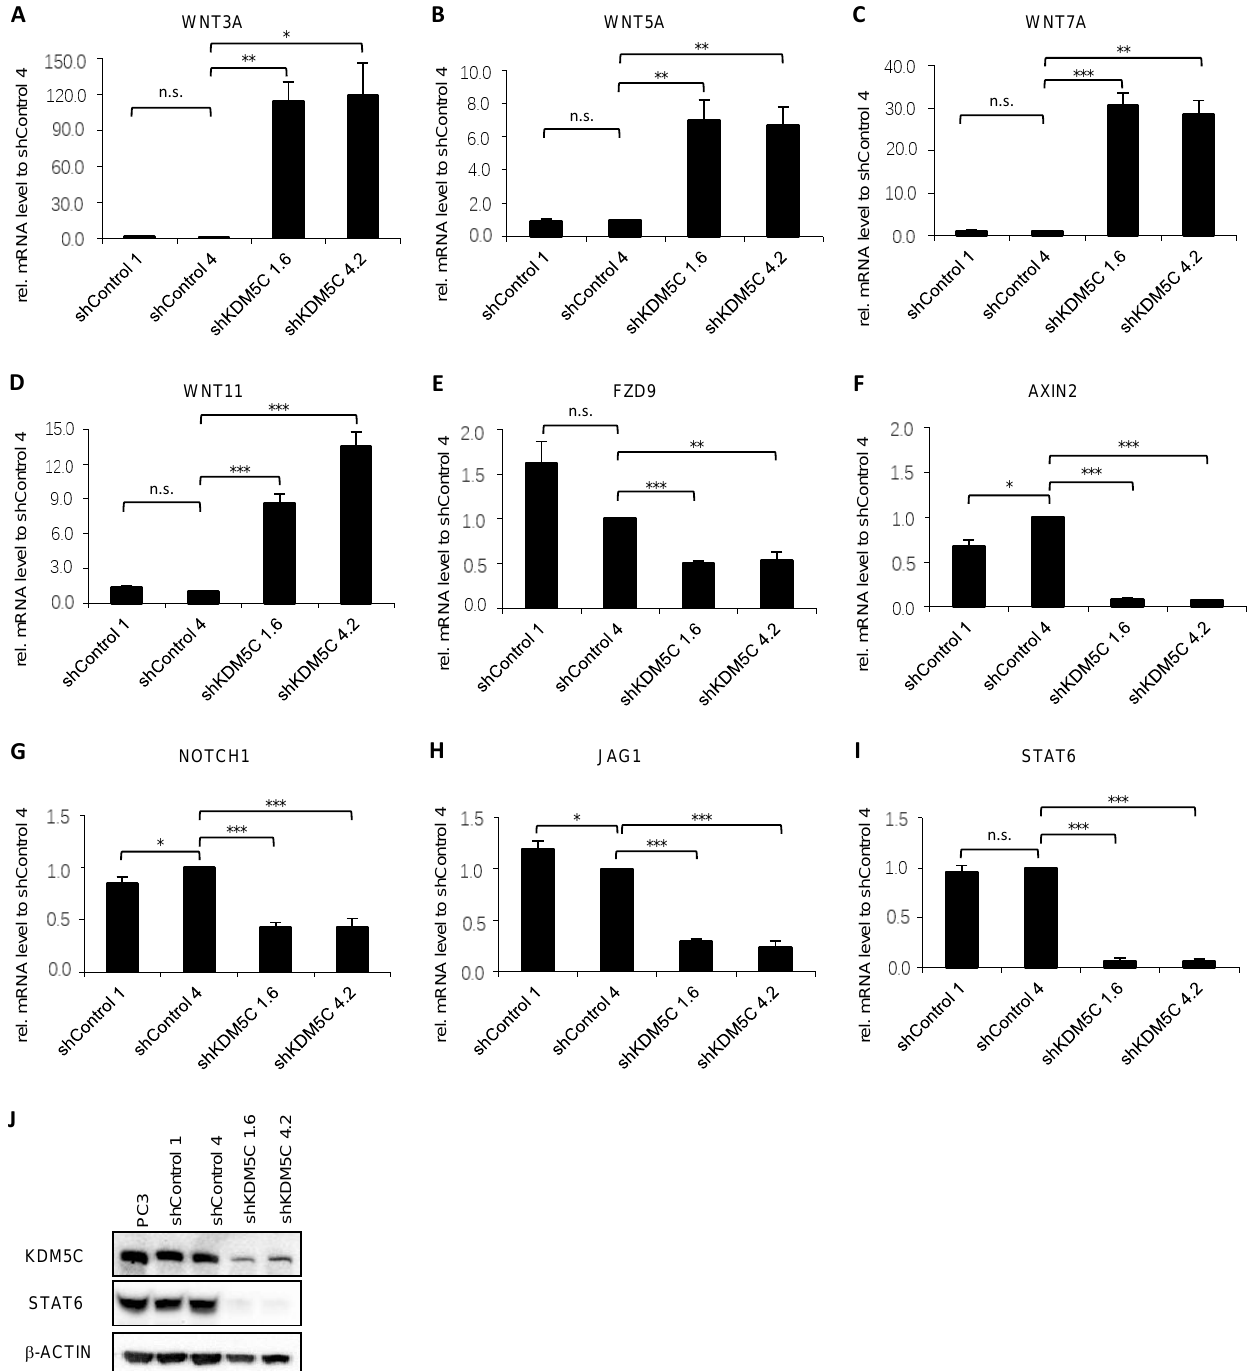
Figure 5. Expression of receptors, ligands, mediator, and target gene of the Wnt ( A – F ) and the Notch ( G – J ) signaling pathways associated with EMT progression. qRT-PCR analysis of mRNA expression in GFP control as well as KDM5C knockdown clones. Important ligands (( A ) WNT3A; ( B ) WNT5A; ( C ) WNT7A; and ( D ) WNT11 ); receptor (( E ) FZD9 ); and mediator (( F ) AXIN2 ) for the Wnt signaling were examined. For the Notch signaling important receptor (( G ) NOTCH1 ), ligand (( H ) JAG1 ), and its target gene (( I ) STAT6 ) were examined. mRNA expression was normalized to the nuclear house- keeper TBP and in relation to the shControl 4 control clone. Error bars represent standard error of the mean from three independent experiments. ( J ) Representative Western blot of the expression of STAT6 in PC3 cells and the shRNA- transduced cell clones. β -ACTIN serves as a loading control. KDM5C shows the knockdown of KDM5C in shKDM5C 1.6 and shKDM5C4.2. (n.s. = not significant; * = p < 0.05; ** = p < 0.01; *** = p < 0.001).